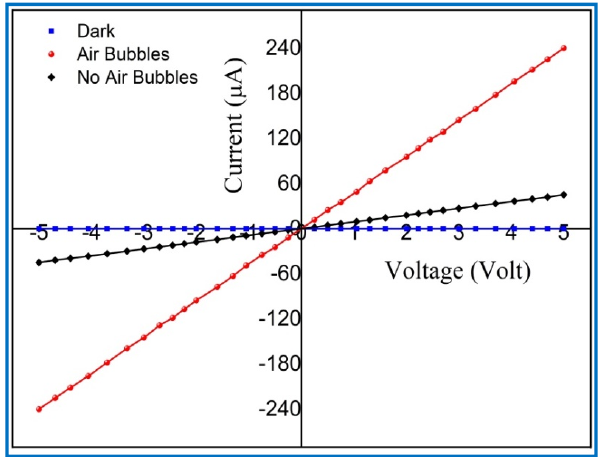
Figure 17. The current-voltage (I-V) characteristics of the (Al/ZnO nanorod) UV photodetectors under dark and UV illumination (380 nm, 0.61 mW/cm 2 ).